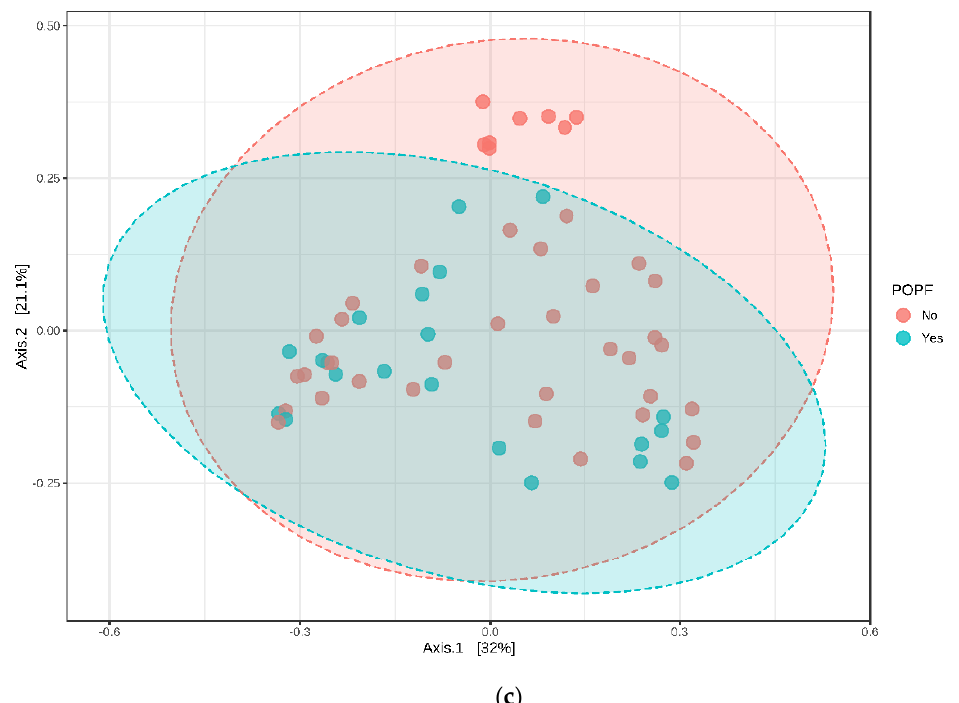
Figure 6. Bar plots representing the microbiome comparison of patients with no POPF (No) vs. patients with clinically relevant POPF (Yes). ( a ) phylum level; ( b ) genus level; ( c ) beta diversity comparison between the two groups shown by PCoA plot (PERMANOVA, Jaccard index, p -value < 0.012, F-value 1.8926, R = 0.030) in no POPF (No, red) and POPF (Yes, blue).